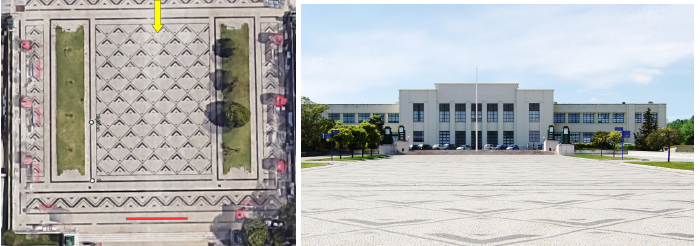
Figure 16. Local A: University Campus. ( Left ) Satellite view. ( Right ) Ground-level photograph.